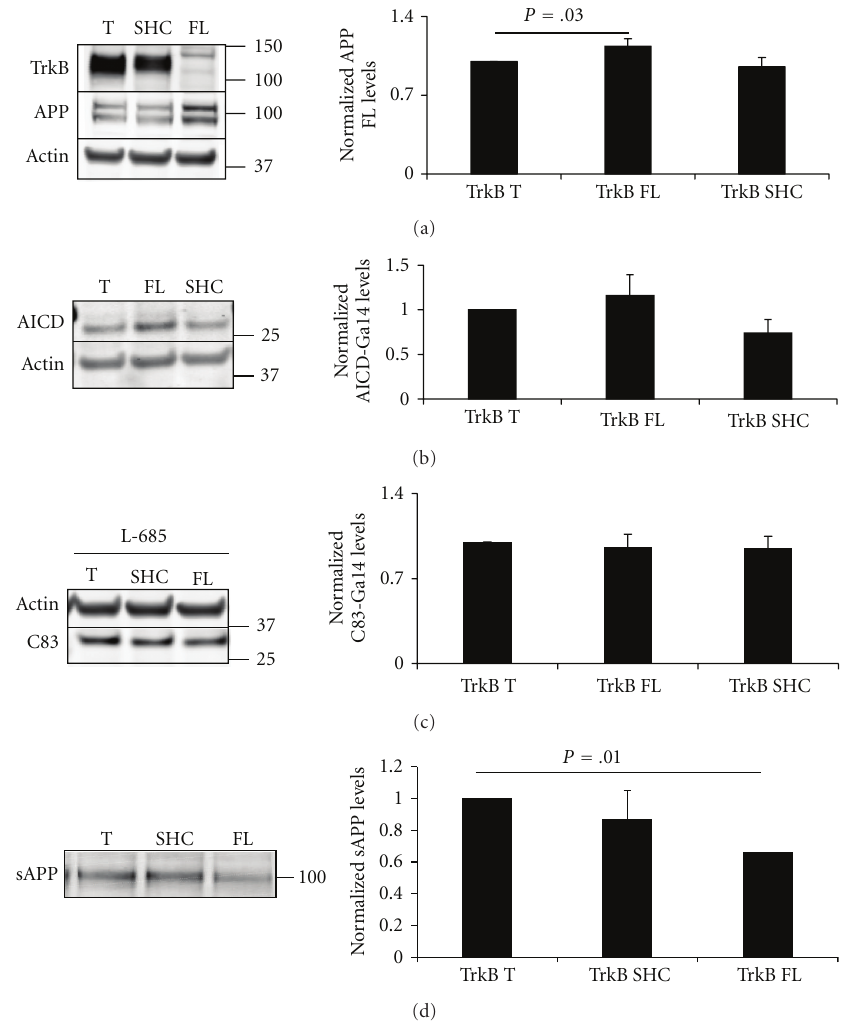
Figure 5: TrkB isoform overexpression a ff ects APP FL levels and APP processing. (a) TrkB FL increases APP FL levels compared to TrkB T ( P = . 03) and TrkB SHC isoforms ( P = . 008). 5 independent experiments in duplicate, error bars indicate SEM. (b) TrkB FL increases AICD levels compared to TrkB T and TrkB SHC decreases AICD levels. (c) TrkB FL, TrkB T, and TrkB SHC do not alter C83 levels. Cells were treated with L-685,485 to aid in C83-Gal4 visulaization (d) sAPP levels in conditioned media. TrkB FL significantly decreases sAPP levels compared to TrkB T ( P = . 003). The experiment was repeated four times independently in duplicate. Error bars indicate SEM. Statistical analysis: Students t -test with Bonferroni correction.